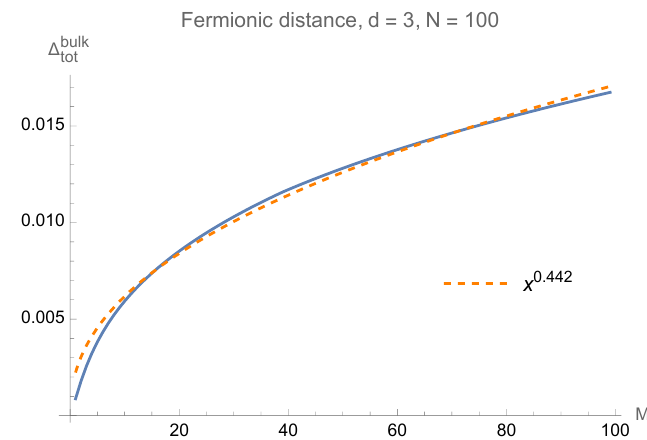
Figure 7 . Fermionic distance for d = 3 , N = 100 and M ≤ 100 . The square-root behaviour is fitted with a power-law model. The accuracy of the fit is limited by the range M ≤ 100 , over which our method shows numerical